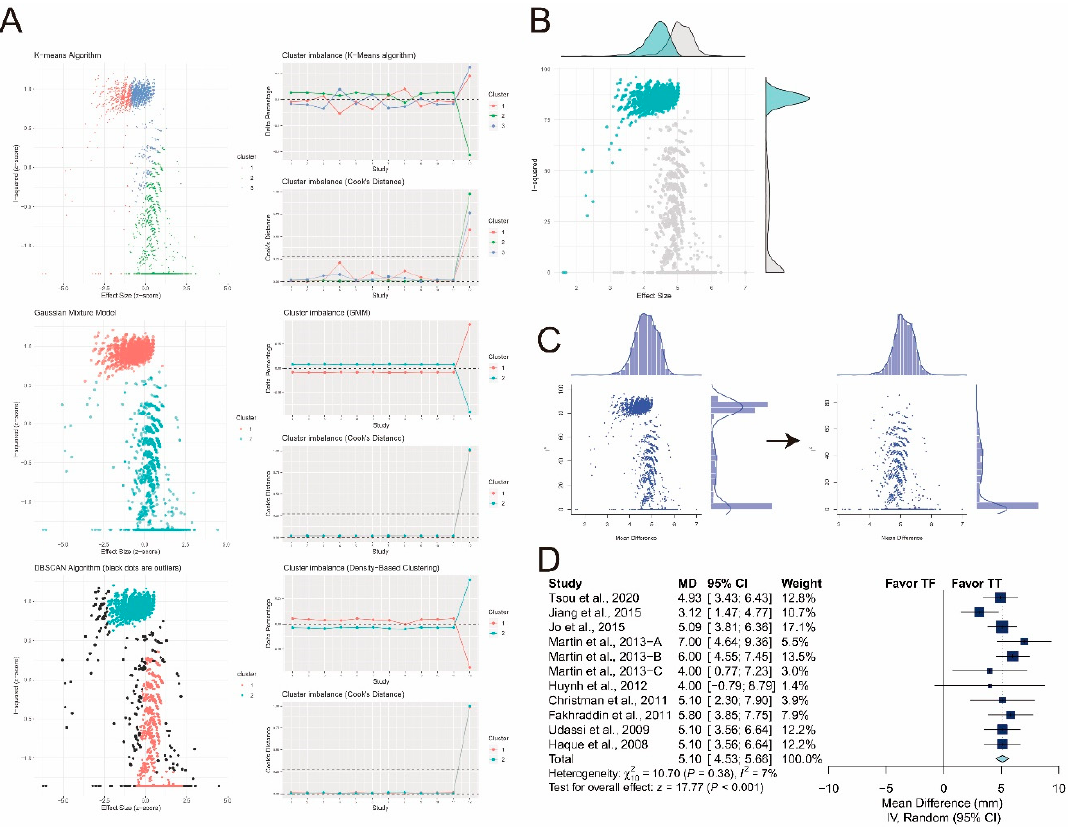
Figure 11. ( A ) Potential outliers identified by three unsupervised-learning algorithms; ( B ) graphical display of study heterogeneity (GOSH) plots with corresponding subsets including potential outliers colored in cyan; ( C ) (left) original GOSH plot; (right) GOSH plot after excluding potential outliers; ( D ) forest plot after excluding potential outliers.